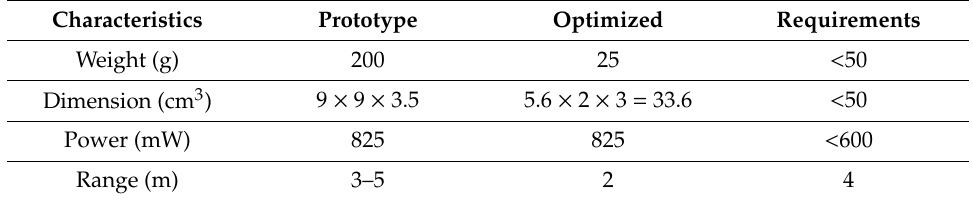
Table 6. Comparison between the prototype and the optimized module (Ultra-wideband radar).